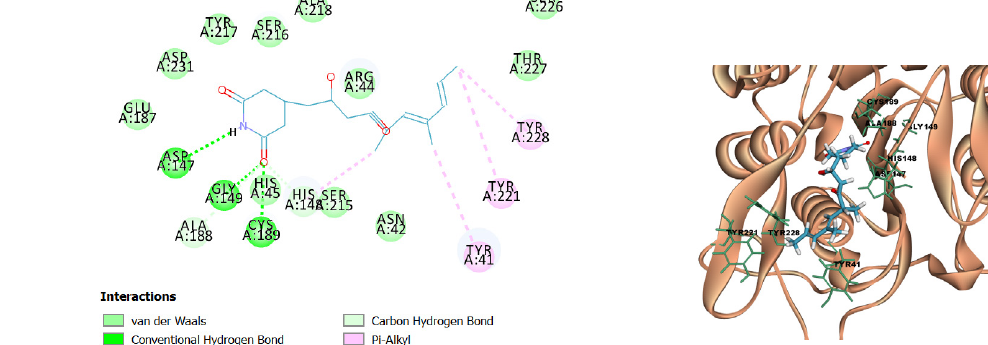
Fig. 6B. 3D diagram showing interactions of 9-Meth- ylstreptimidone at LGMN catalytic site.